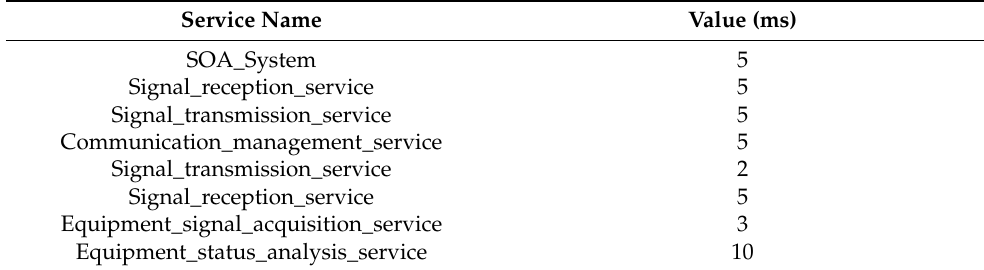
Table 2. The delay time of services in SOA_System.